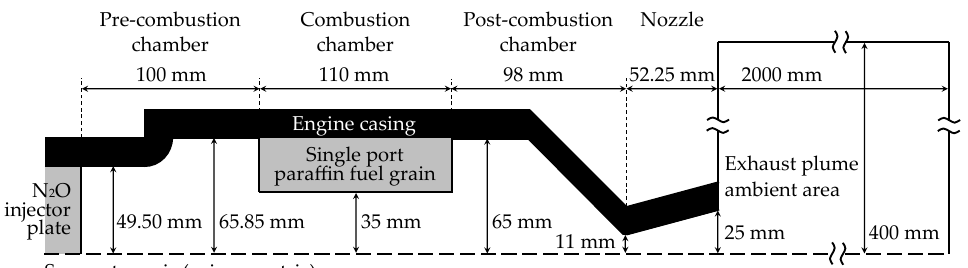
Figure 6. Computational domain (white area) and its